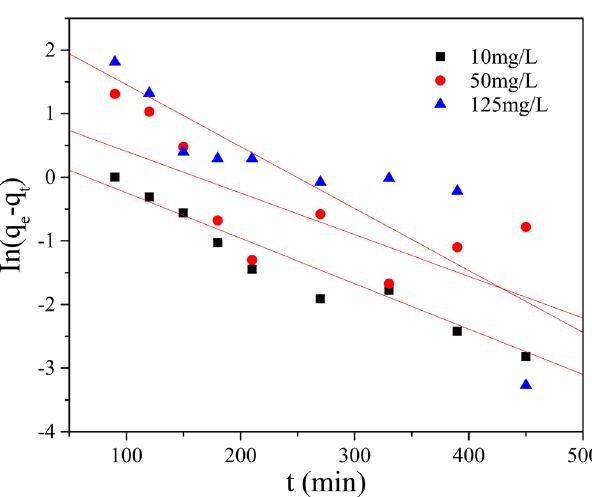
Figure 10. Pseudo -first order reaction